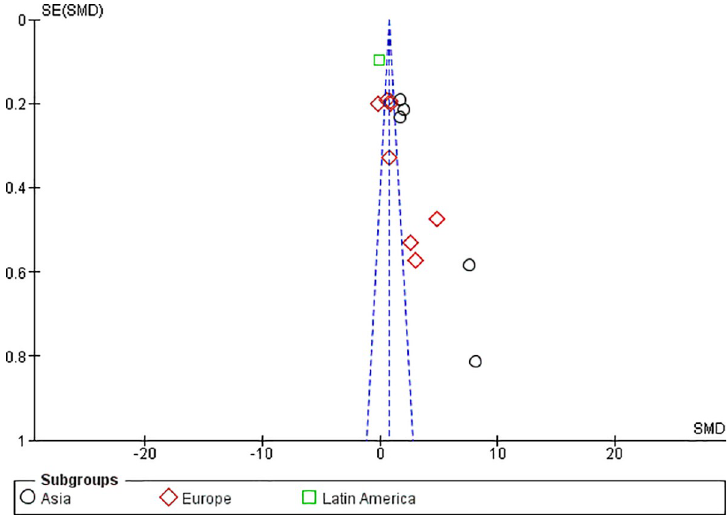
Fig 10. Funnel plot showing the publication bias of studies. Small studies with larger effect sizes are shown in the right lower side of the plot.